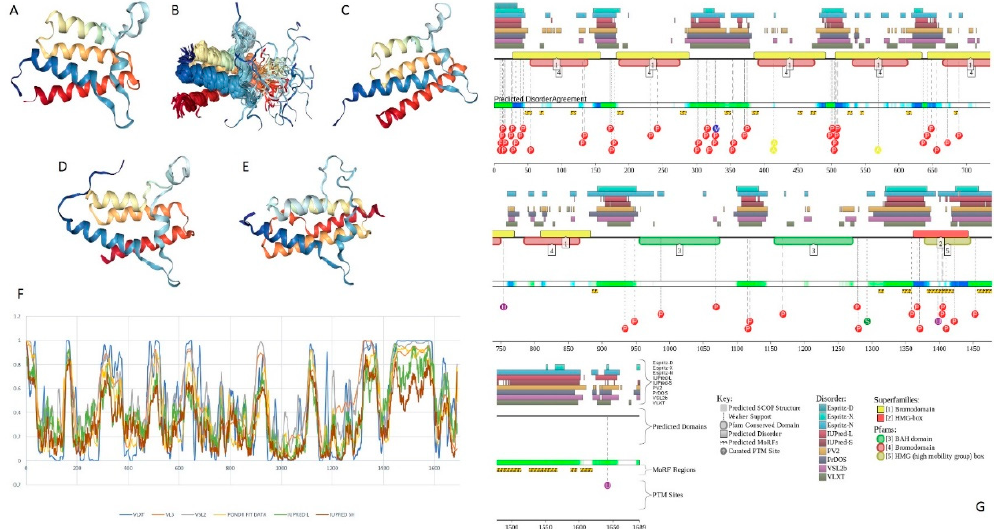
Figure 13. Structural organization of the human BAF180 protein. ( A ) X-ray crystal structure of